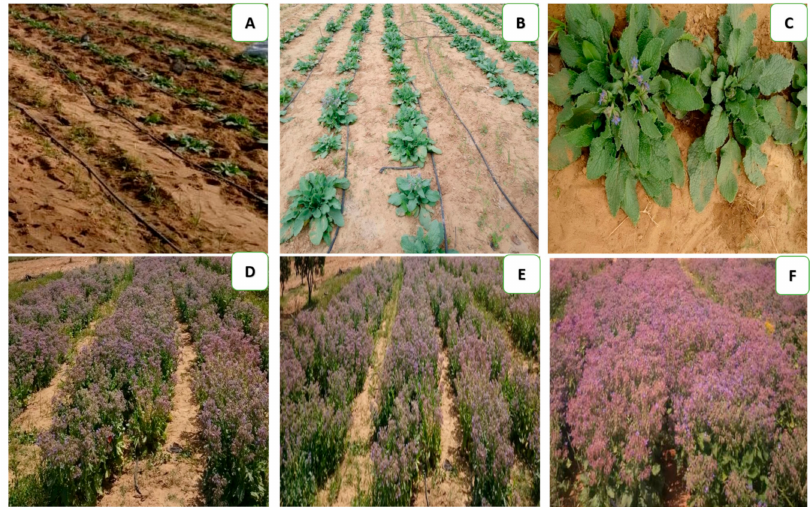
Figure 2. Layout of the experiment, ( A ) plants after thinning; ( B ) vegetative growth; ( C ) the beginning of flowering; ( D – F ) full